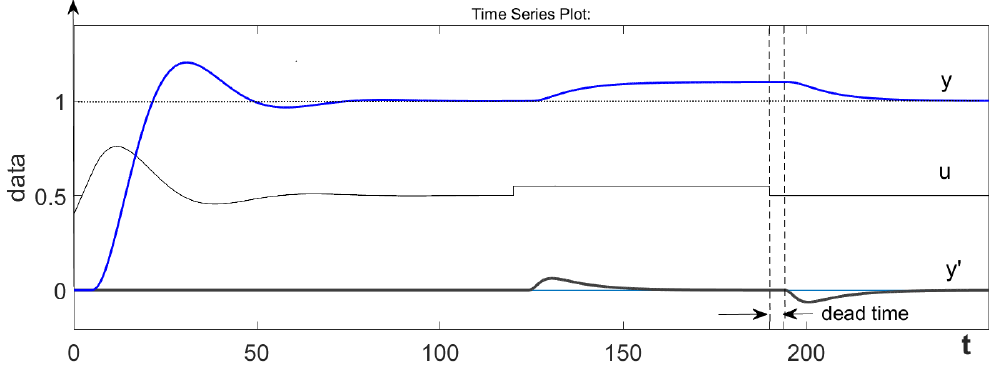
Figure 2. Time series of selected variables during the pretest.